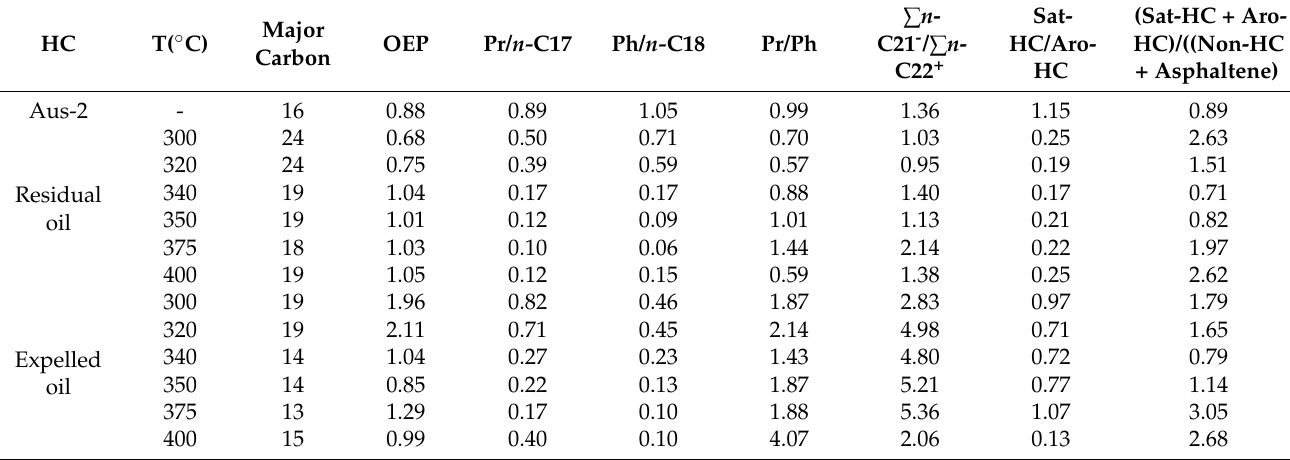
Table 3. Isoprenoid and n -alkane ratios from GC in expelled oil and residual oil of different temperature pyrolysis products from